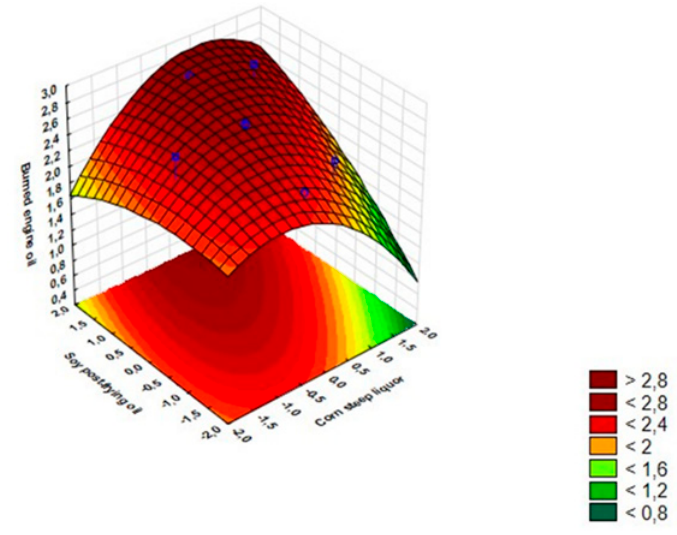
Figure 3. Response surface graph for interactive effect between concentrations of corn steep liquor (%) and waste cooking oil (%) on EA in motor oil.